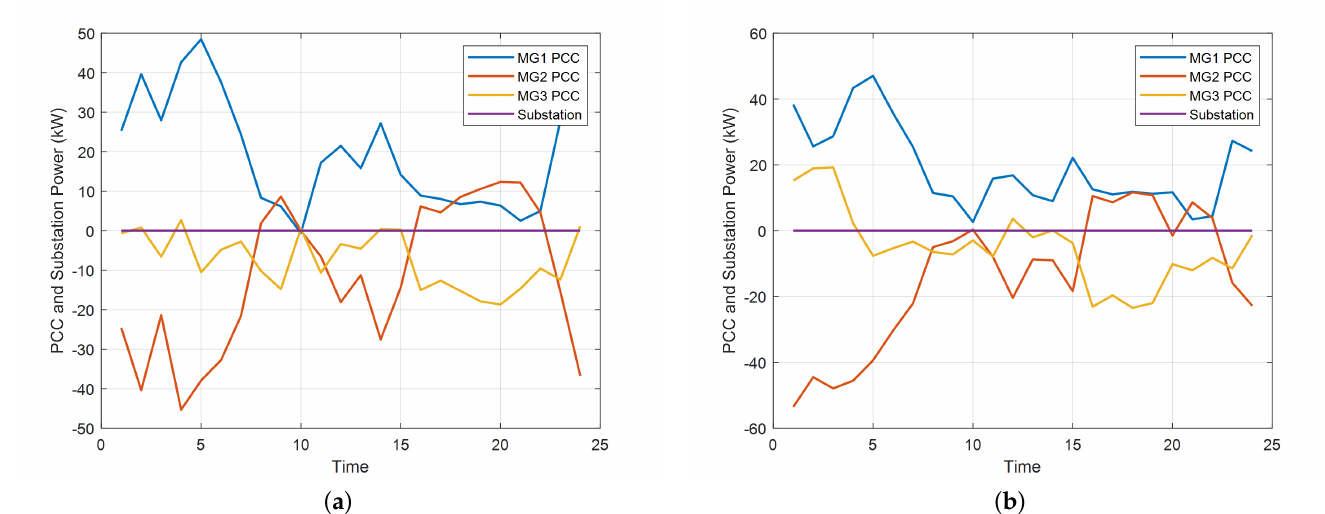
Figure 8. Calculated PCC power by different methods in islanded mode. ( a ) Centralized optimization. ( b ) MILP-based distributed